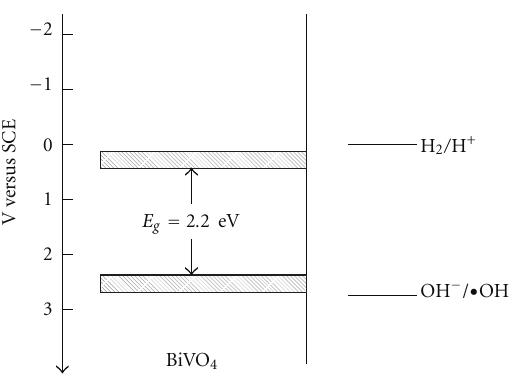
Figure 9: Energy scheme at the BiVO 4 /electrolyte